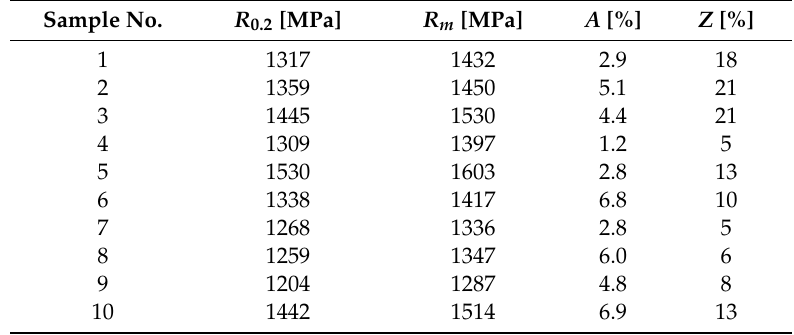
Table 3. Results of static tensile testing of 1.2709 steel samples (Instron 3382). Sample